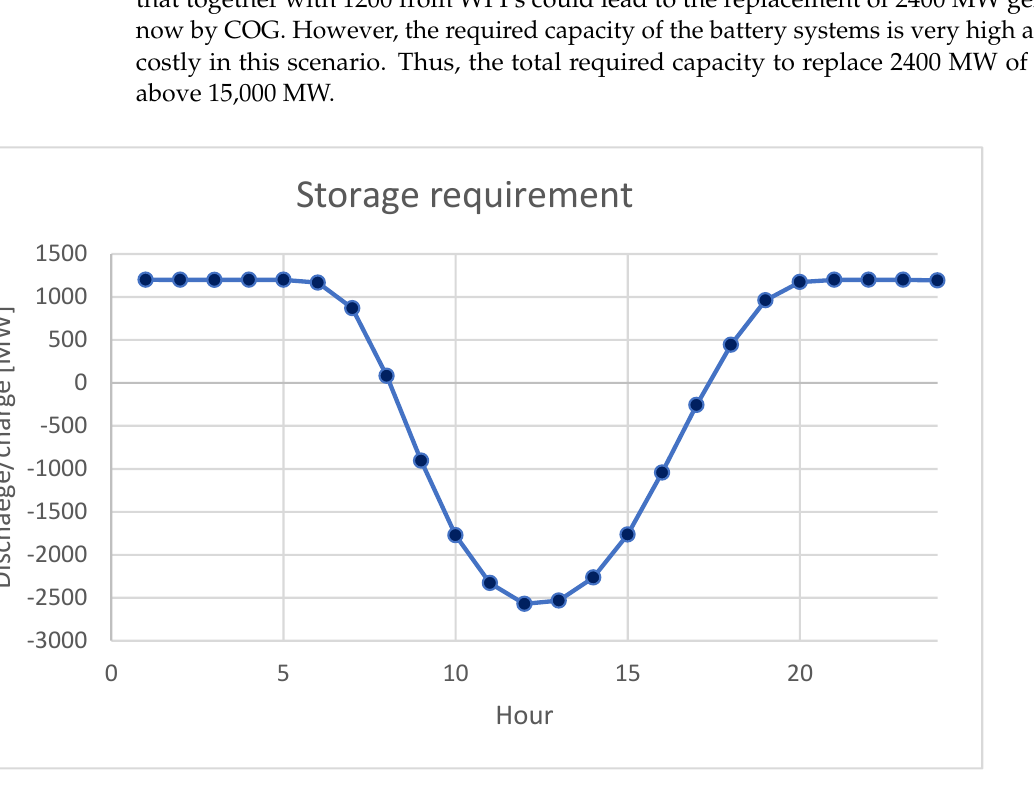
Figure 11. Storage capacity in scenario 2 in the case of 2400 MW replacement of COG.